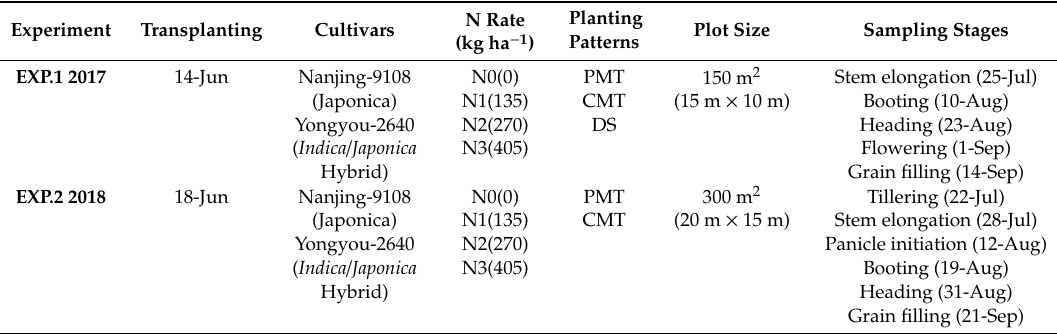
Figure 1. Study site: the rice experiment was conducted at the Taizhou Experimental Station in Jiangsu Province of China in 2017. Table 1. Basic information about experimental design and data acquisition.